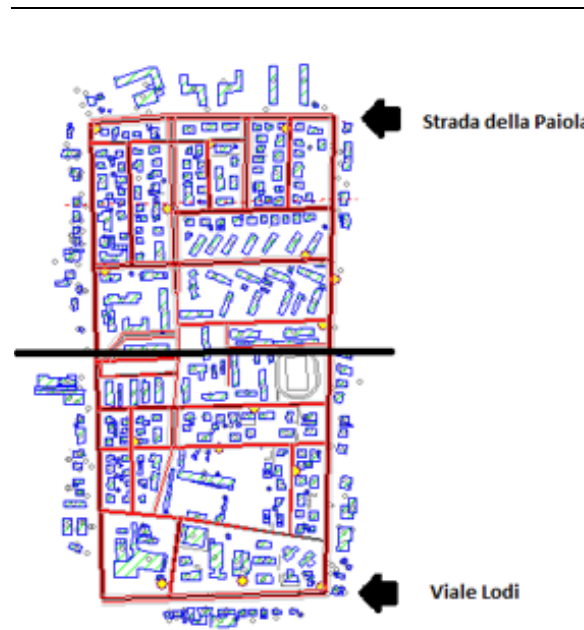
Figure 8: The two roads considered for the AQI calculation